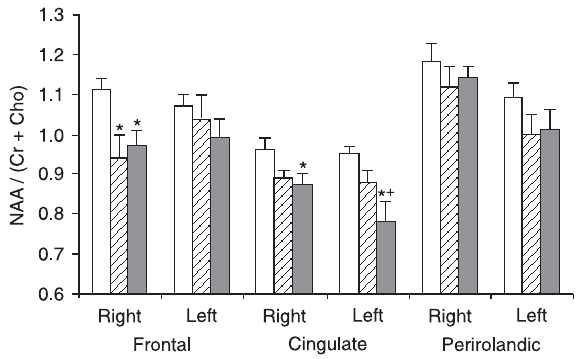
Figure 3. NAA / (Cr + Cho) ratio for the control group (N = 37; open bars), patients with normal conductance levels (N = 18; stripped lined bars) and schizophrenic patients with low conduc- tance levels (N = 19; closed bars) in the frontal, cingulate and perirolandic cortices. Asterisks indicate a statistically significant difference compared to controls and the plus indicates a signifi- cant difference between the subgroups of schizophrenics